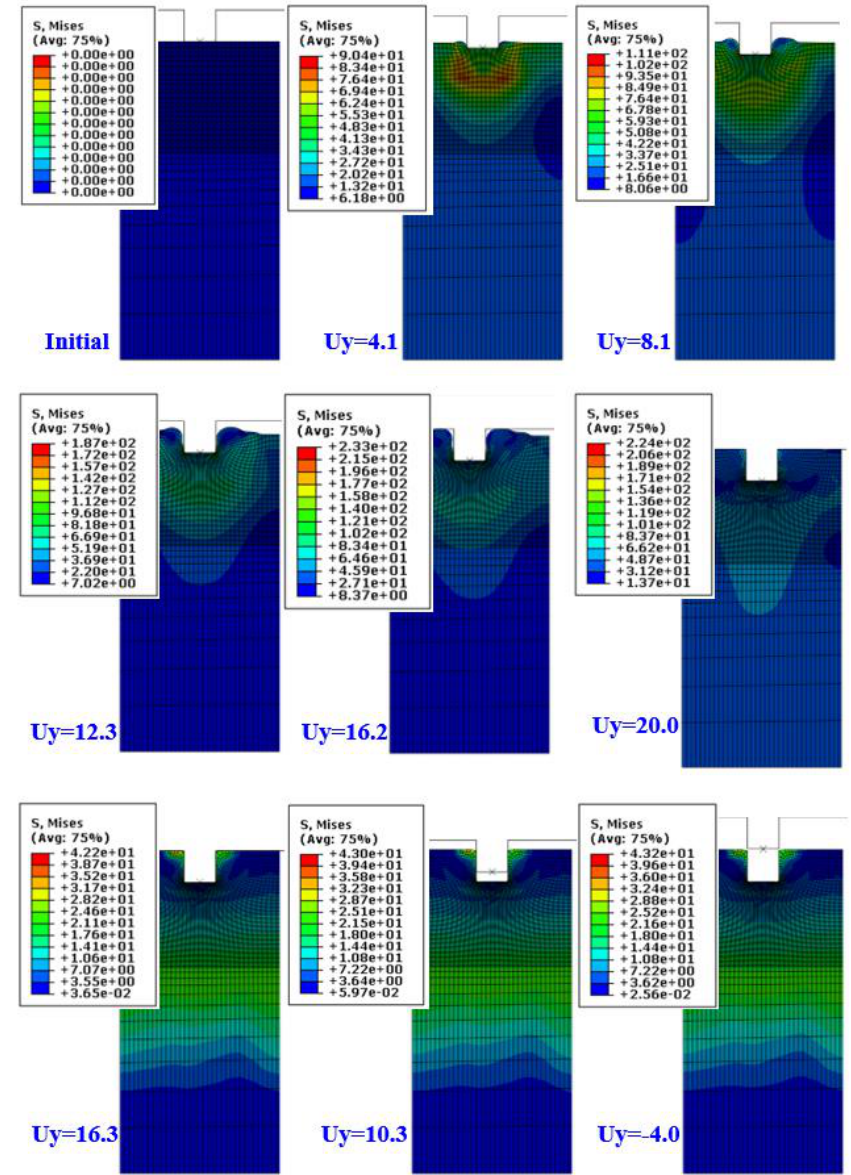
Figure 8. Deformed shape and von-Mises stress distribution (Tool: 100 °C, Sheet: 25 °C).